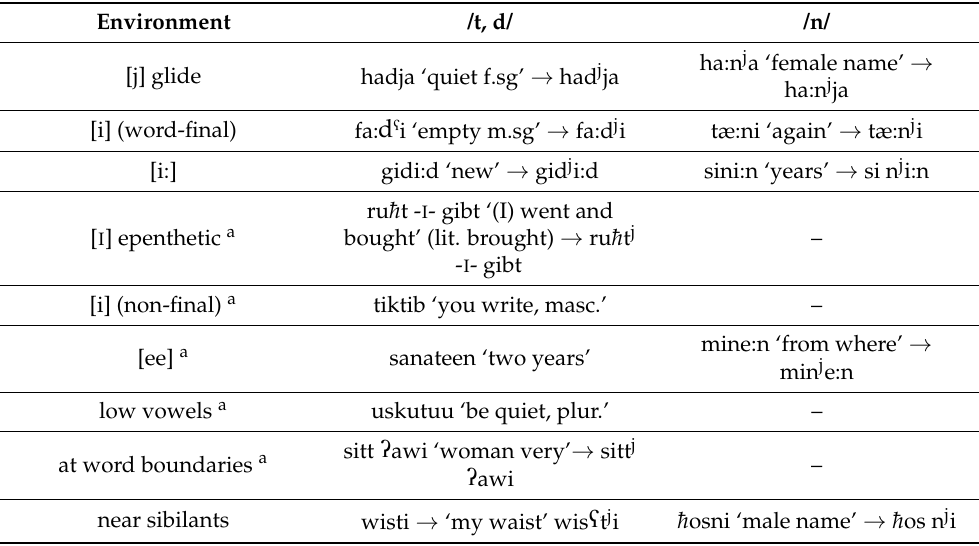
block or lack WP.